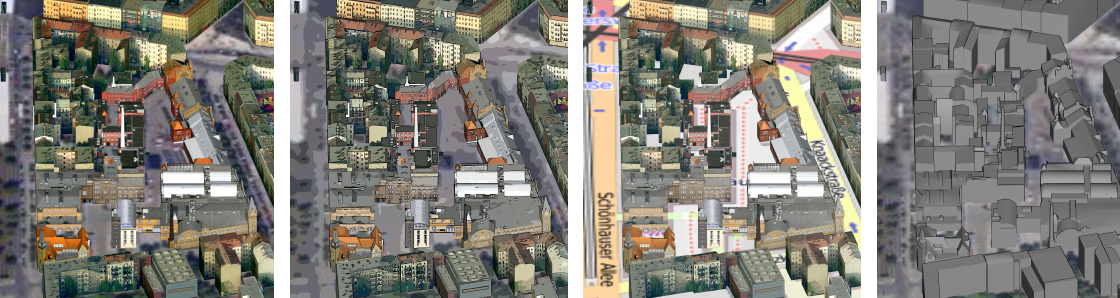
Figure 4: Examples for different styling methods available in the rendering backend. Stylization allows to tailor the look of an application, e.g., to have a more realistic, abstract, or a more focused appearance on client side. 4 different stylizations are depicted for comparison: (a) textured facades, (b) an image abstraction filter was applied to remove details from the image, (c) an OpenStreetmap was applied on the terrain, and (d) the buildings are rendered using a simple shaded style to focus on the building